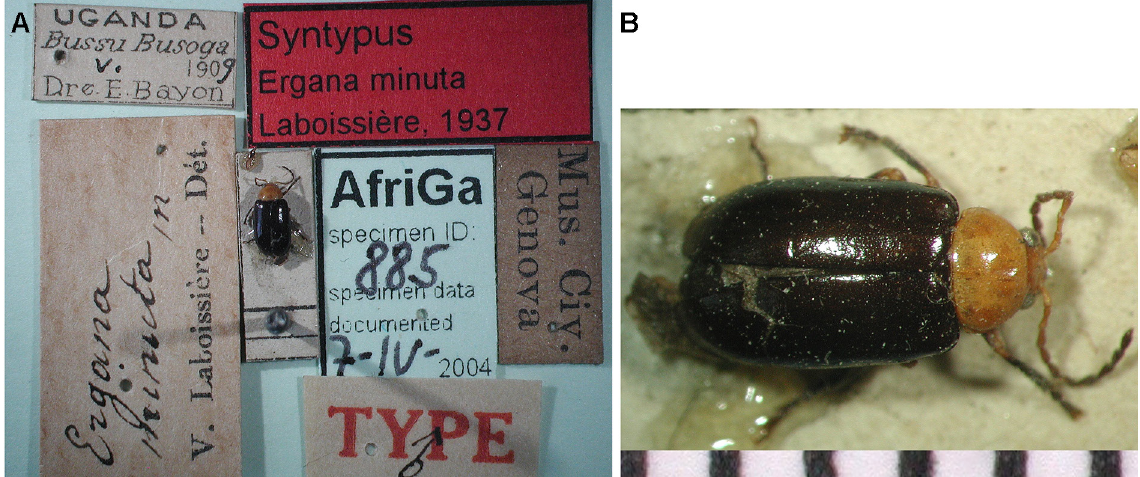
Fig. 14. Lectotype of Oosagitta minuta comb. nov. A . Overview with labels. B . Close-up of specimen.